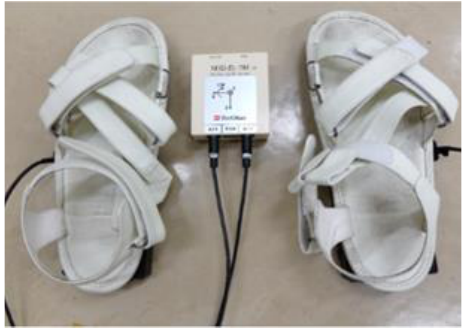
Figure 4. Example of experimental data. (a) Before turning, (b) Start of turning, (c) During turning, (d) End of turning.